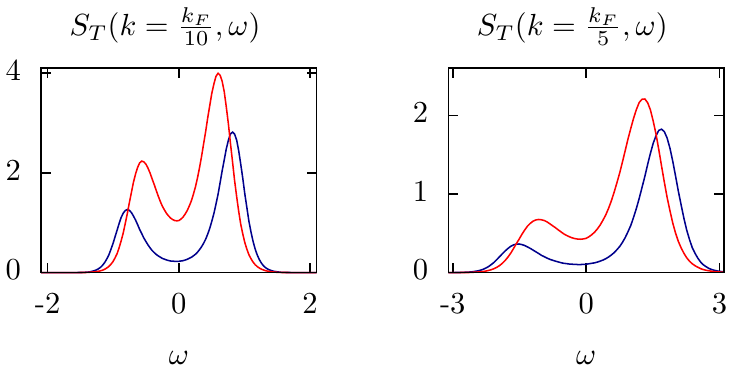
/ 10 (left) and k = F